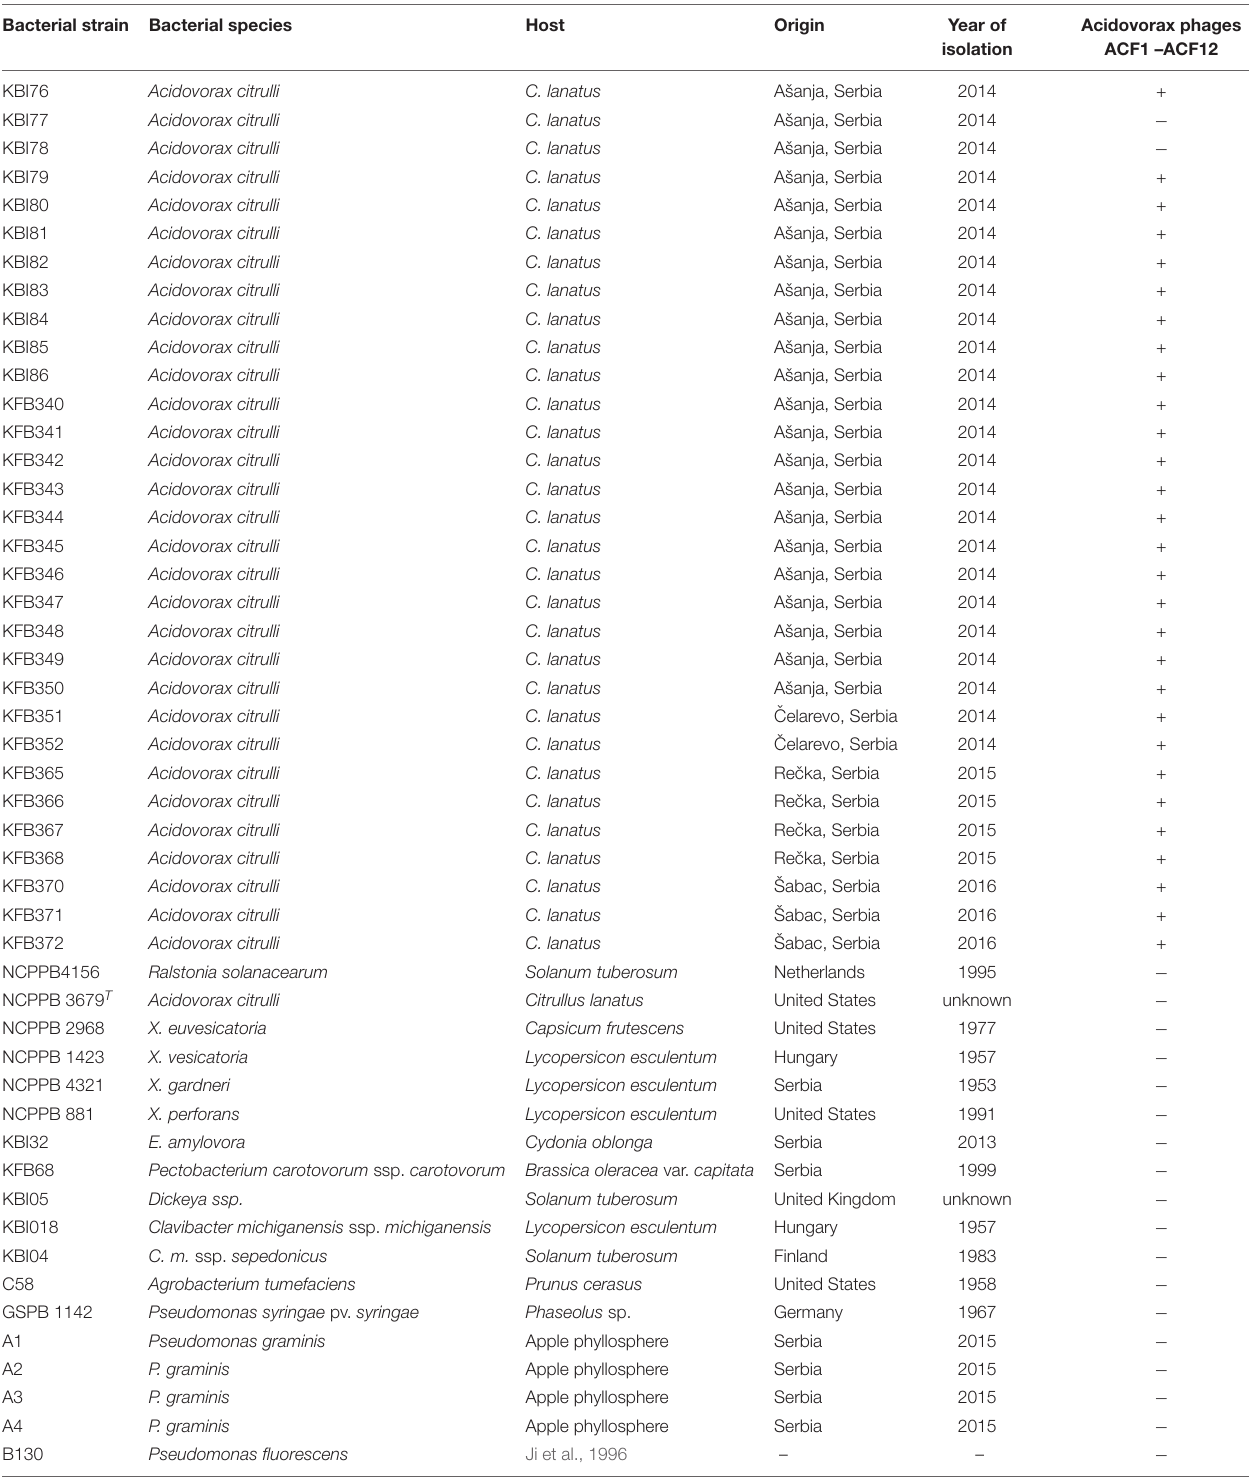
TABLE 1 | The host range of studied bacteriophages. Bacterial strain Bacterial species Host